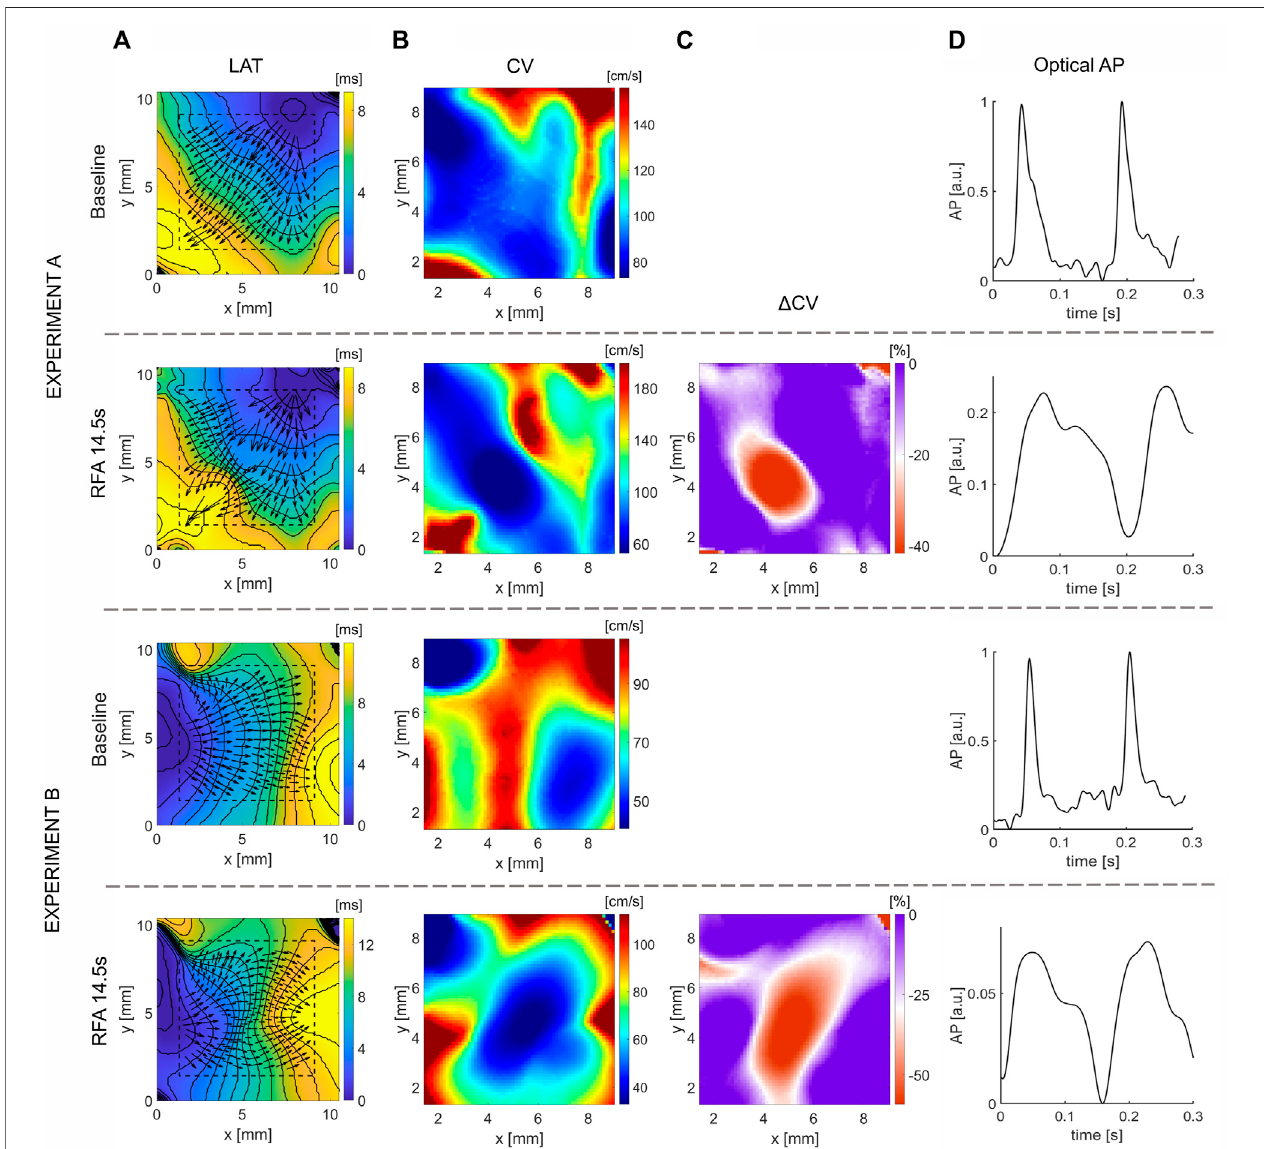
FIGURE3| Effect ofablation onCV slowing onisolated ratatria. (A) LATmapobtainedbefore (Baseline)and afterRFA forthetotaldurationof14.5 sand powerof 10 W,approximatelyat thecenterofthemap, alongwiththesuperimposed CVvectormap. (B) RespectiveCVmaps obtainedwiththeCMmethod forselecteddashed square regions presented in (A) outline the ablated areas as regions of CV reduction. (C) Relative change, Δ CV, between the CV maps after and before the ablation, showsalargerelativedecreaseofCVintheablatedareas,delineatingtheablatedareafromnon-ablated,suitableforcharacterizationoftheablatedareaboundary. (D) OpticalAPtracesfromapixelinsidetheablated area,normalized beforeablation,showthereductioninAPamplitude andmorphologychanges.Thecolorbar range in all fi gures is set from the 5th to 95th percentile, except for Δ CV maps ’ upper boundary that was set to zero. Radius of 10 pixels (1.3 mm), in the CM, was used for CV